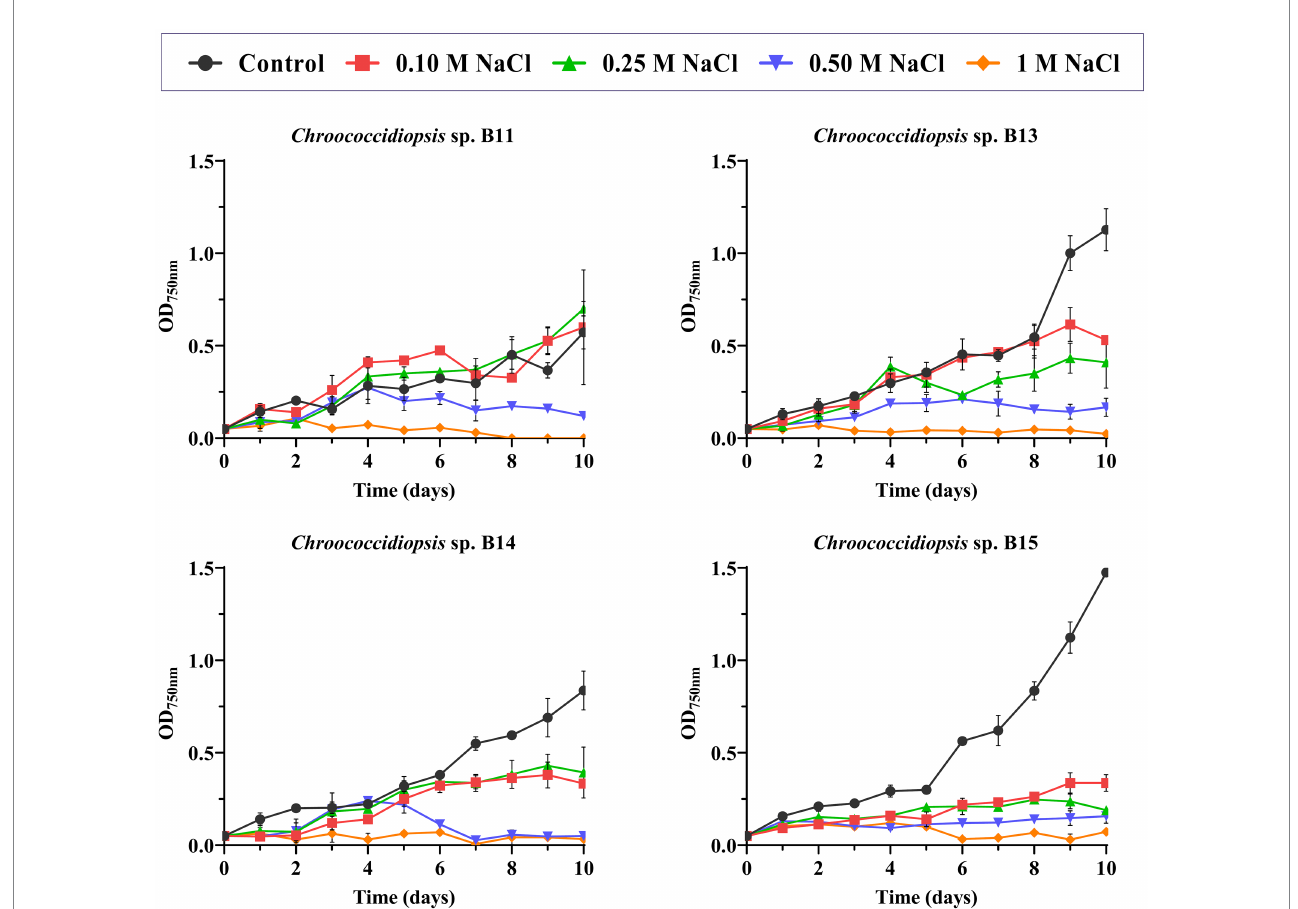
FIGURE 3 Effect of NaCl concentration in Helios isolates growth. As a control, growth in BG11 medium was used. The graph shows the average of three biological replicates together with the standard deviation. The graphs show the average OD 750nm of three biological replicates together with the standard